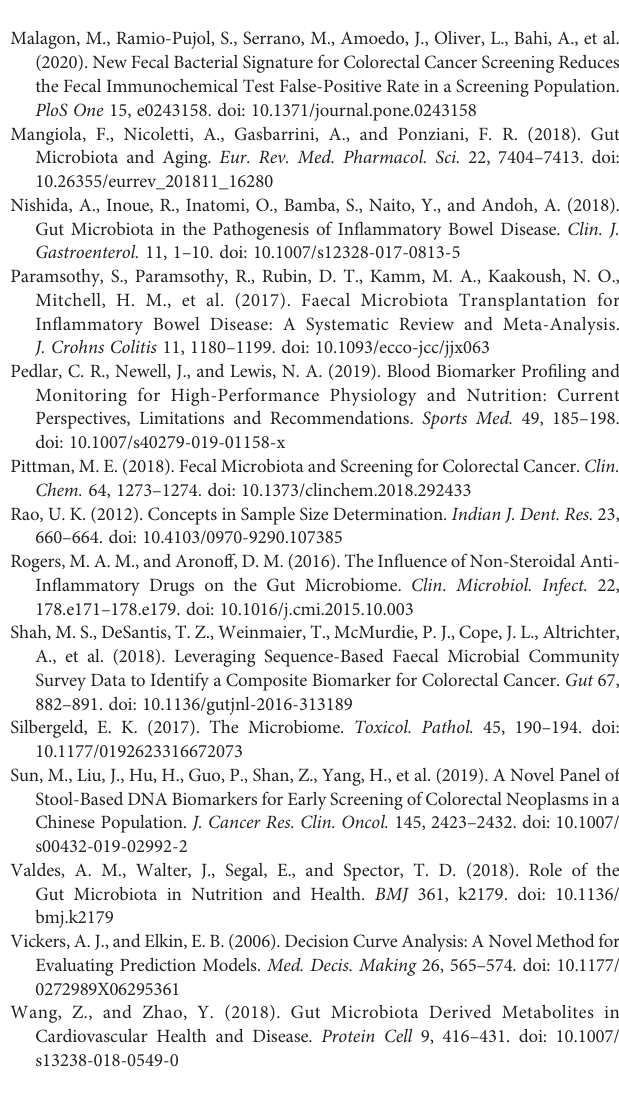
index; TNM, tumor-node-metastasis. Gender by Chi-square; Age and BMI by T-test. Supplementary Table S2 | Primers and probes used in this